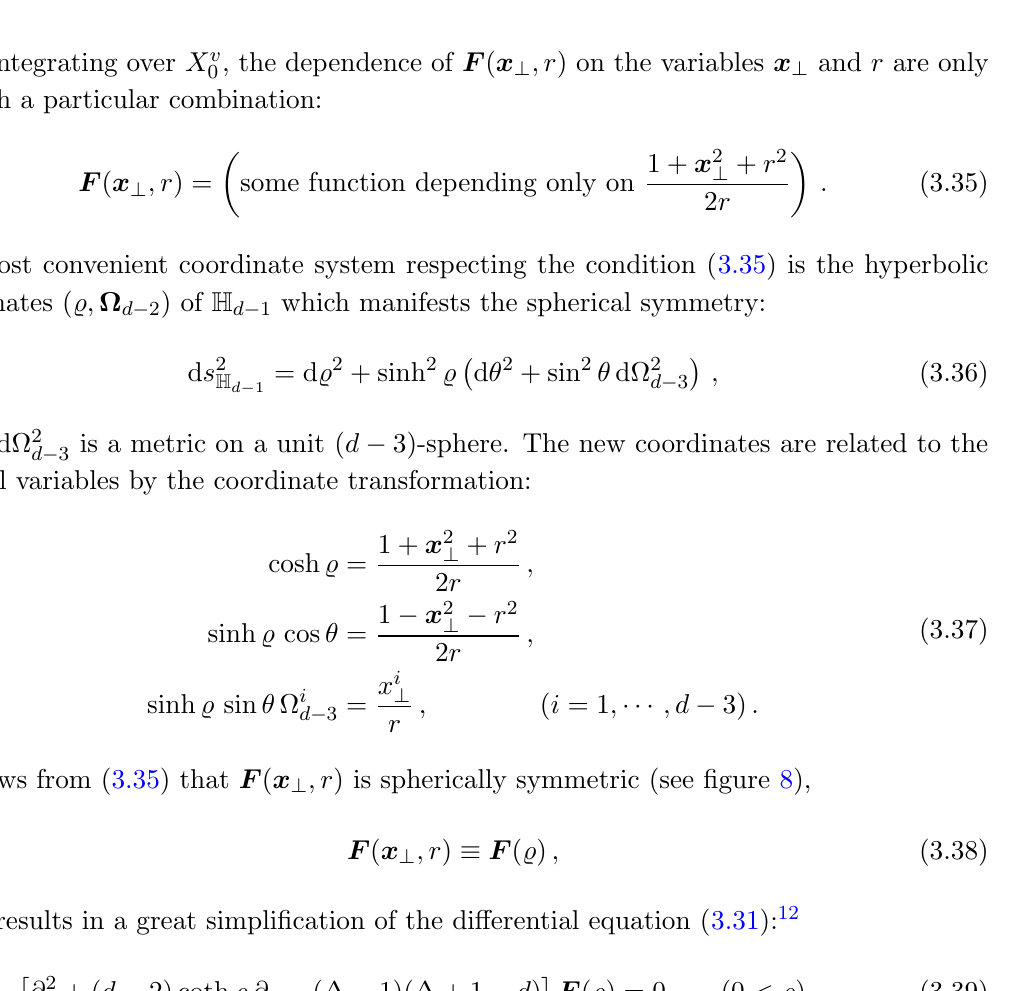
Figure 8 . Two coordinates of a hyperbolic space H d (cid:0) 1 ; ( x ? ; r ) [Left] and ( %; (cid:10) d (cid:0) 2 ) [Right]. A 2 2 constant 1+ x ? + r 2